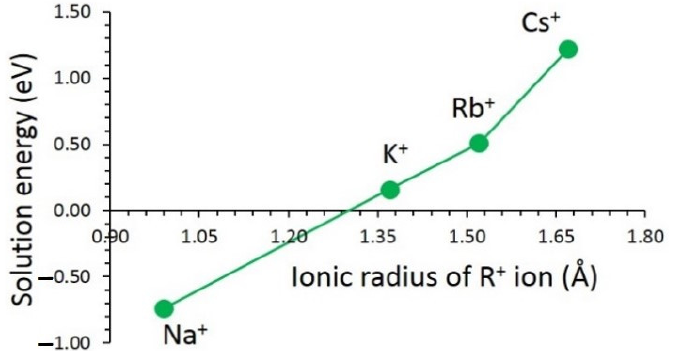
Figure 2. Calculated solution energies of monovalent dopants on the Li site.